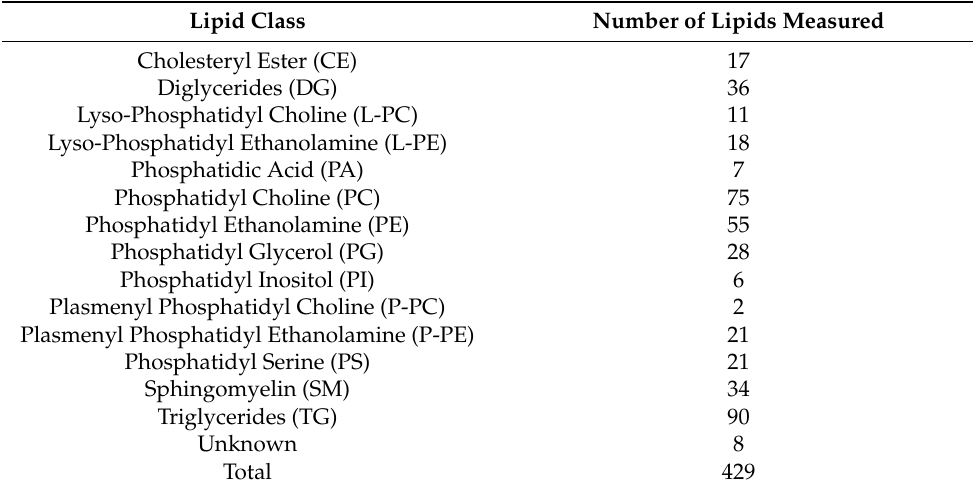
Table 2. List of lipids detected in each lipid class by unbiased mass spectrometry analysis. Lipid